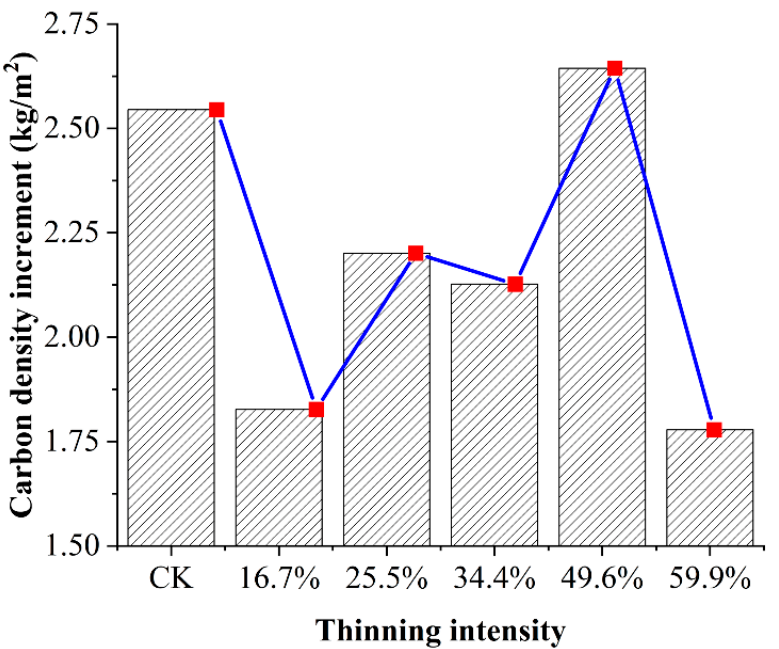
Figure 10. The increment in carbon density after 12 years of thinning.